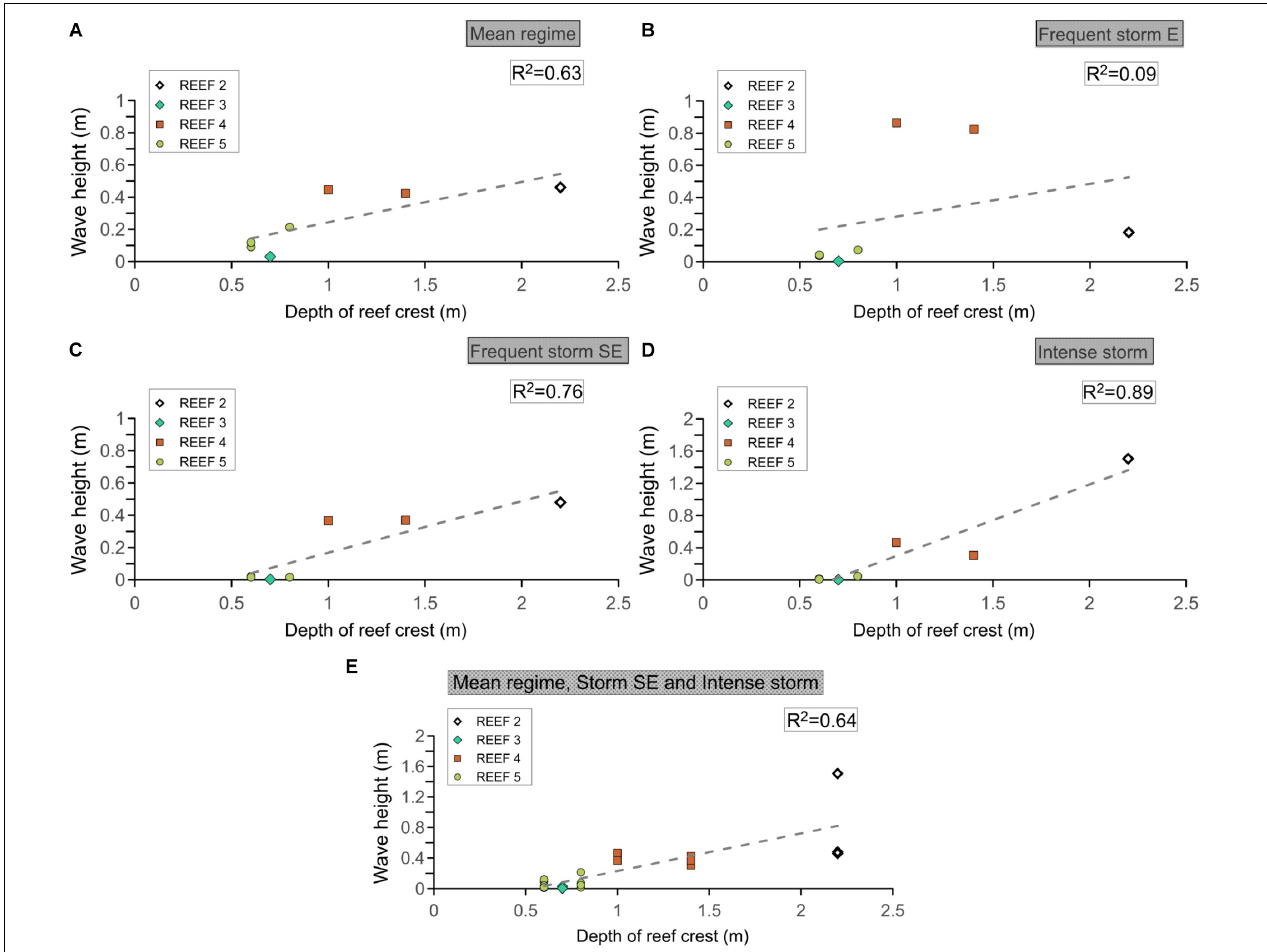
FIGURE 9 | Correlations between breaking wave heights behind the reefs and the depth of the reef crests for different hydrodynamic forcing: (A) Mean regime (regular wave conditions). (B) Frequent storms from the East. (C) Frequent storms from the Southeast. (D) Intense storms (from the East-Southeast). (E) Mean regime, storms from the Southeast and intense storms. The dashed line represents a linear regression line fitted by least squares. R 2 is the square of the Pearson linear correlation coefficient, tested at 95% confidence